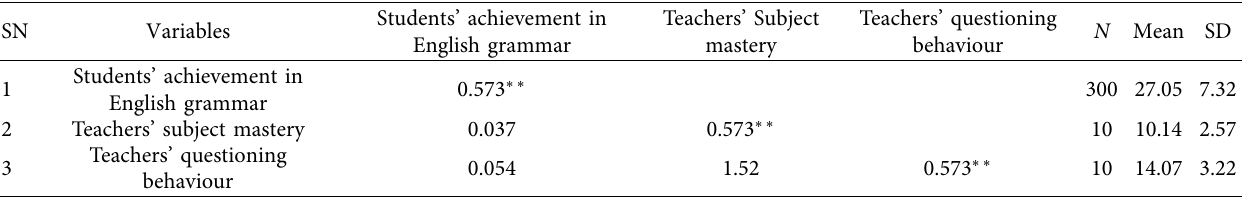
Table 1: The Pearson product-moment correlation showing relationships between teachers’ subject mastery and questioning behaviour and students’ achievement in English grammar.